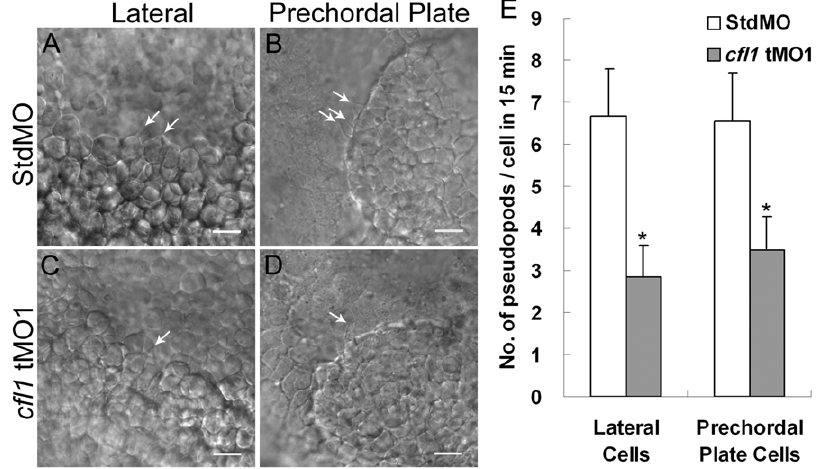
Figure 10. Knockdown of cfl1 inhibits the pseudopod formation of involuting cells. Embryos injected with MOs were dechorionated, immobilized, monitored, and recorded in 15-min continuous time-lapse movies. Lateral cells were monitored from the lateral side (A, C), and prechordal plate cells were monitored from the anterior side (B, D). Representative photographs are shown for each group as designated. Arrows indicate the sites of pseudopods. (E) Number of pseudopods was counted and analyzed for each group. Both lateral cells and prechordal plate cells in cfl1 morphant embryos had significantly fewer pseudopods (* p , 0.05). Only upper error bars of the standard deviations are shown.